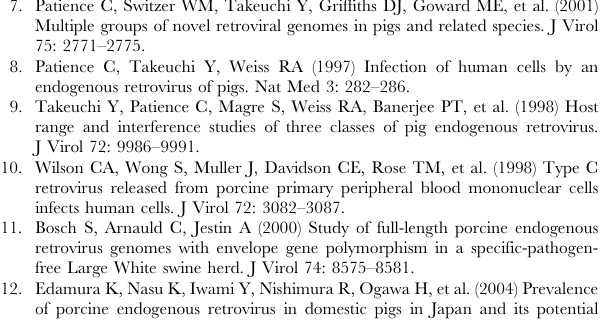
Table S1 Primers used in this